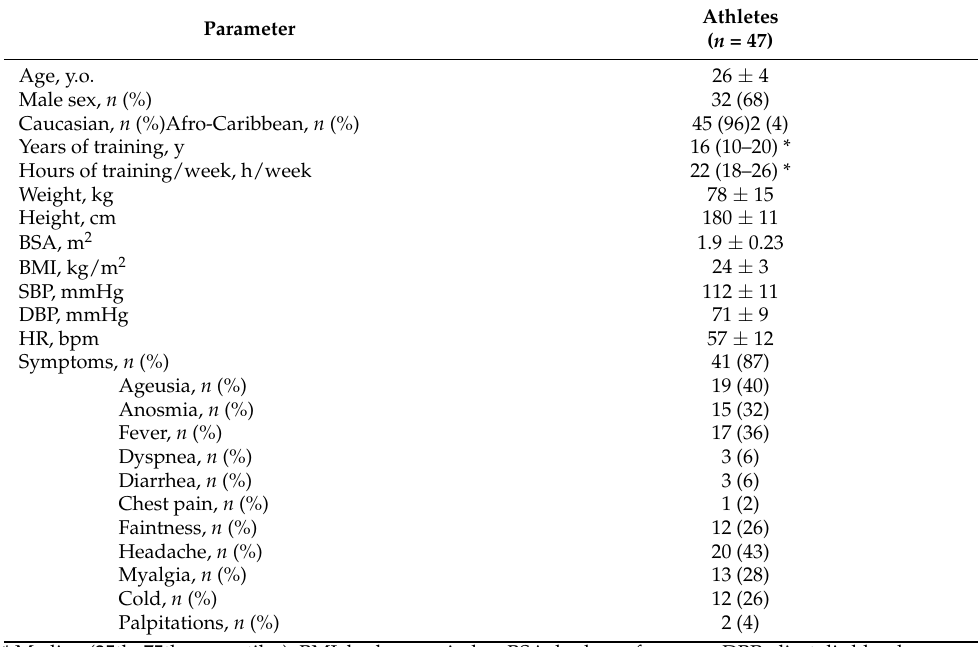
Table 1. Study population and clinical presentation of SARS-CoV-2 infection.